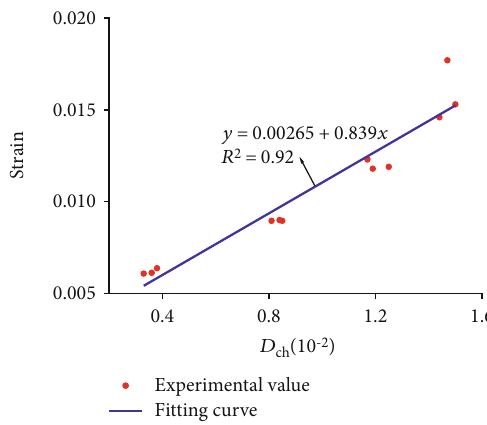
Figure 10: Chemical damage parameters and peak strain.